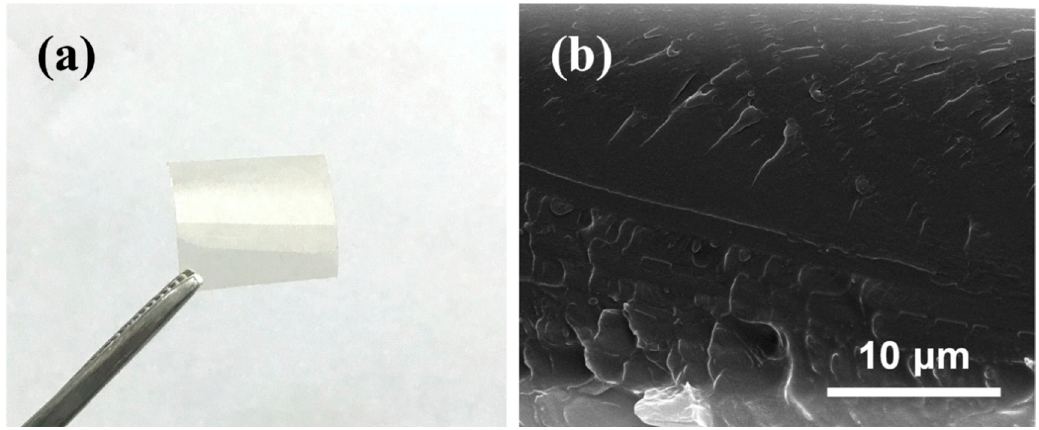
Figure 4. ( a ) The photo and ( b ) cross-sectional SEM images of SCPEN films.